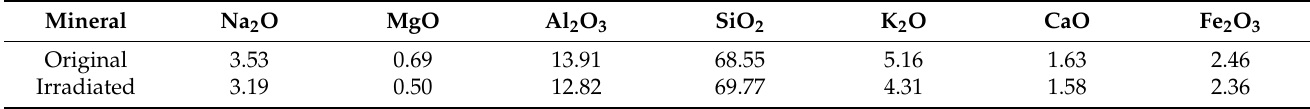
Table 3. Composition of original and irradiated granite